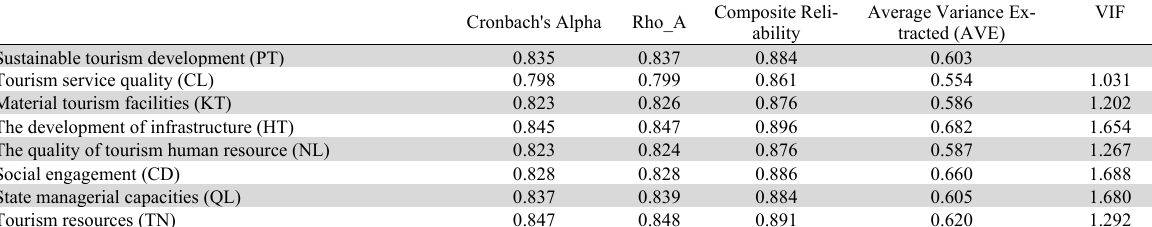
The reliability of the research